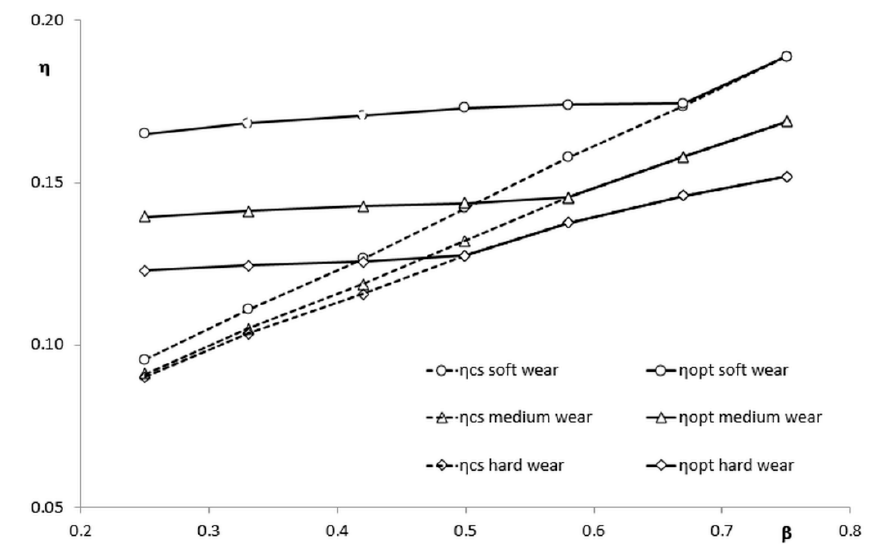
Figure 11. System e ffi ciency in both constant and variable speeds for di ff erent wear Figure 11. System efficiency in both constant and variable speeds for different wear conditions.